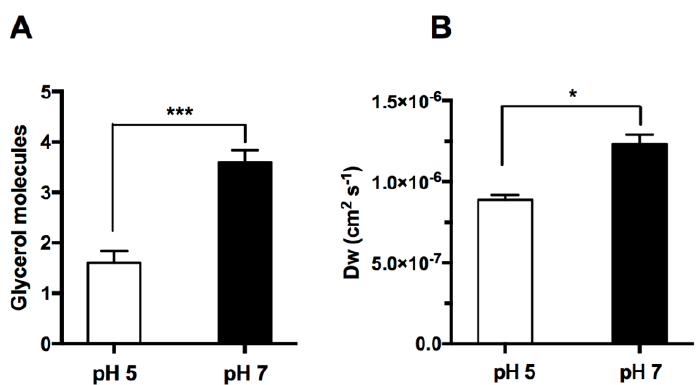
Figure 4. pH dependence of glycerol and water permeation across the hAQP7 channel (in silico). ( A ) Number of glycerol molecules crossing the AQP7 tetramer in MD studies, represented as mean ± SEM (n = 5). ( B ) Water diffusion coefficient calculated by MD simulations, represented as mean ± SEM (n = 3). n = number of simulations. * p < 0.05, *** p < 0.001.